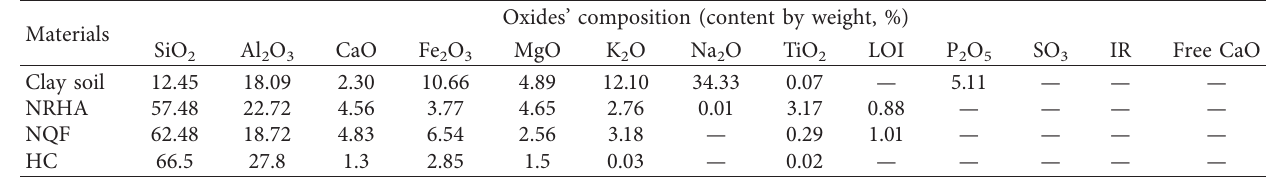
Table 5: Chemical oxides’ composition of the additive materials.